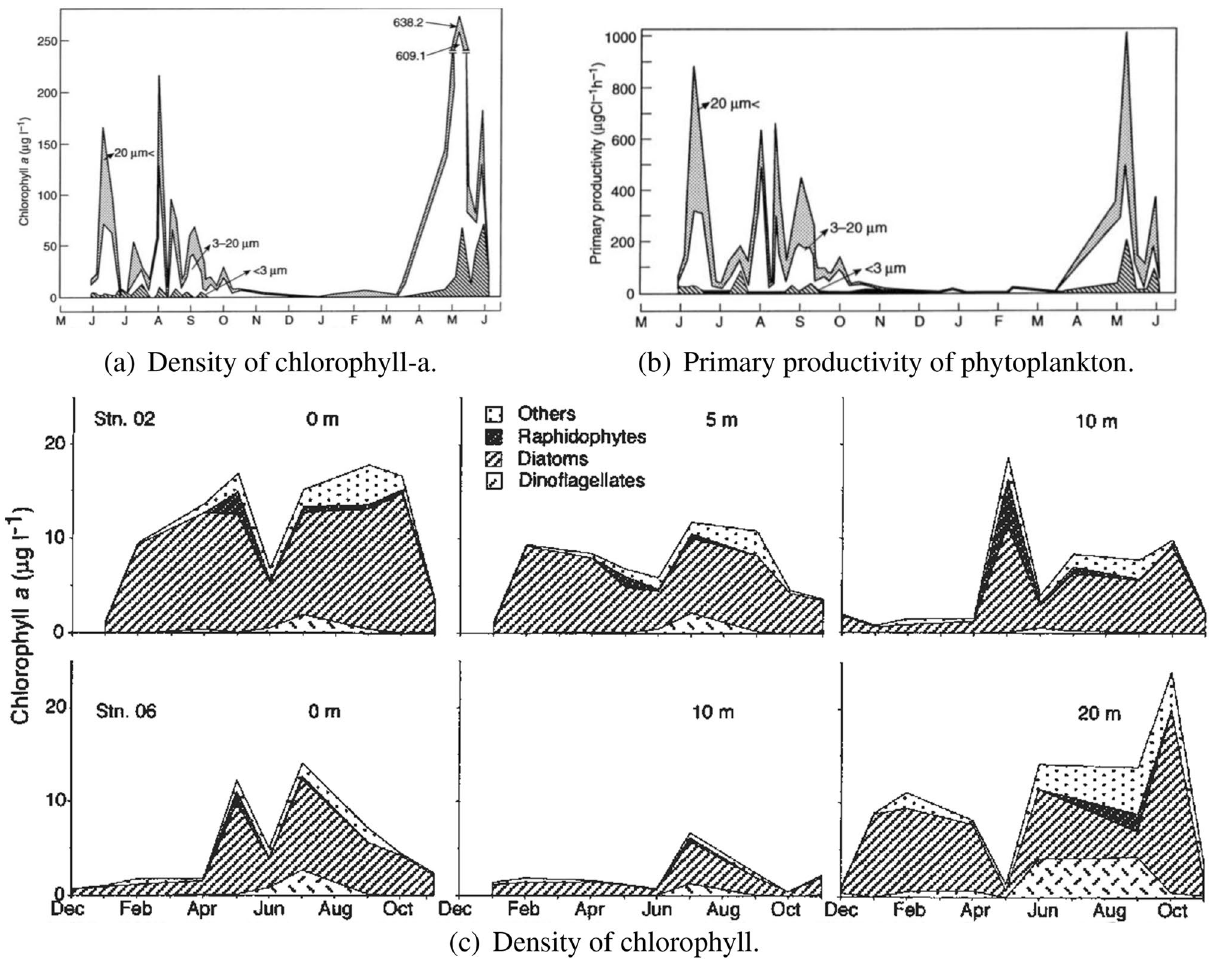
Figure 4. ( a ) Monthly variation in concentration of chlorophyll at the mouth of Arakawa river (collected from 36 ). ( b ) Monthly average primary productivity of phytoplankton at the mouth of Arakawa river (collected from 36 ). ( c ) Overall seasonal variation in the concentration of chlorophyll at region 4 and around region 4 35 data was collected in May 2011, productivity should be highest here, which results in higher value of C for this region. Hence, values of ε will be near to 0.035 for this zone. Region 4: Inside Tokyo Bay (different location). Data was collected from a depth of nearly 50 m inside Tokyo Bay (Region 4) during the months of Dec 2006, Sep 2007 and Feb 2008. It is observed that each season represents different kind of phytoplankton distribution at that particular region (Fig. 1d,e,f). Dec, 2006. During the month of December, average daylight and sunshine hours at and around Region 4 are 9.8 h and 5.7 h respectively (Fig. 2a), which are low compared to that of the previous months. Also, yearly observed report provided by weather atlas (Fig. 2b) indicates low solar radiation intensity (UV index the month of December. Since sea-surface temperature is mostly controlled by these three important factors, it cannot increase significantly. However, due to 108.7 mm rainfall (Fig. 2c 38 ) and 0.8 average snowfall days 38 , sea-surface temperature also decreases, which results in low average sea-surface temperature (17.2– 19.5 ◦ C) 39 . These environmental factors not only control temperature of water but also influence salinity. Region 4 is nearer to the northern part of Pacific ocean, so salinity of this zone is higher than that of Region 3. It is observed that as depth increases, salinity also increases (Table 2). Also, according to the yearly observational data regarding chlorophyll density in and near region 4 between 1997 to 1998, chlorophyll density remains comparatively low during winter season (Dec–Feb). This means maximum growth of phytoplankton is low, productivity of phy- toplankton reduces and its density decreases. In such a scenario, without any loss of generality, we consider the mortality rate ( D ) of phytoplankton is high enough so that density of nutrient increases (NP system is closed). Since, at the depth of nearly 50 m of Region 4 in the month of December, C was low and D was high, range of ε will be (0.35–1.0) (as shown in case of Region 1).